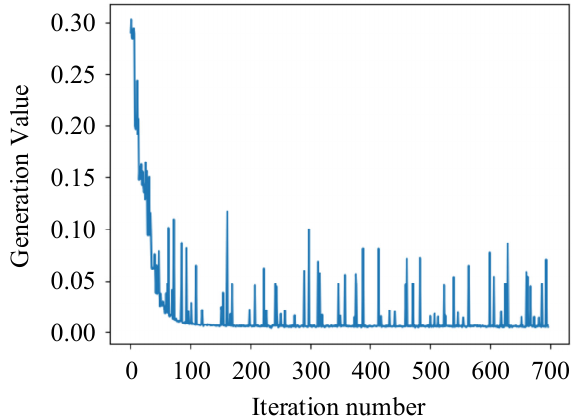
Figure 9. Abnormal iterative process.